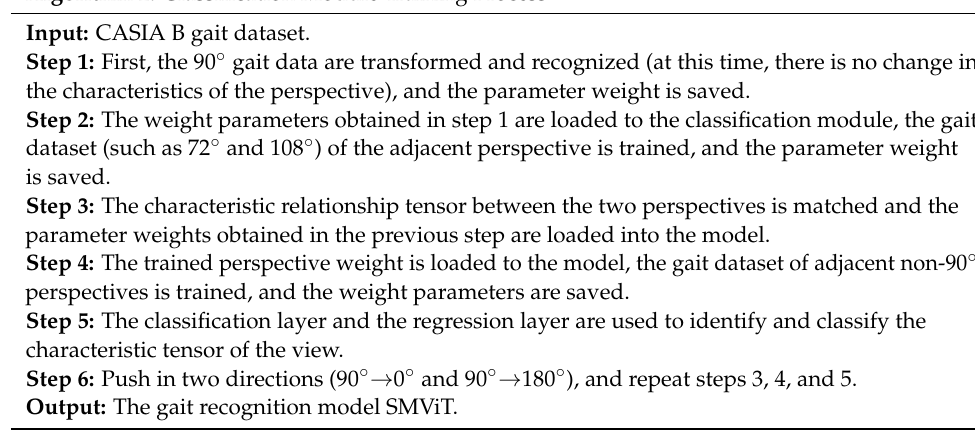
Algorithm 2: Classification Module Training